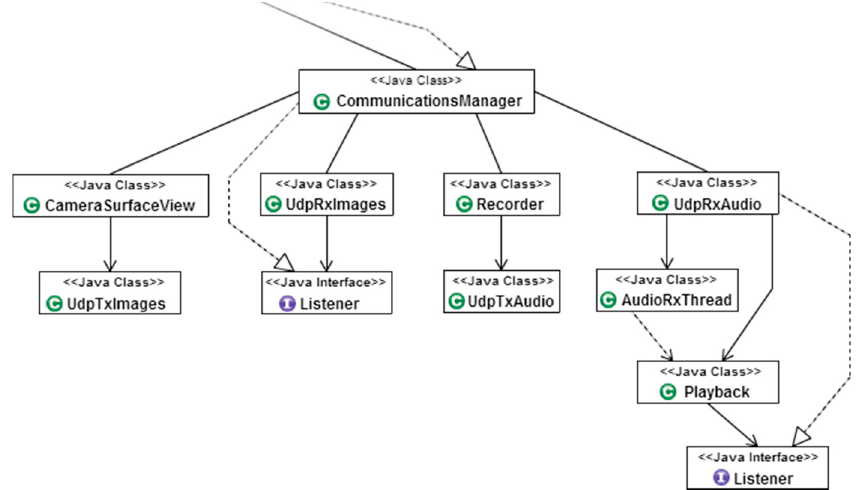
Figure 8. Depiction of the videoconference system hierarchy.